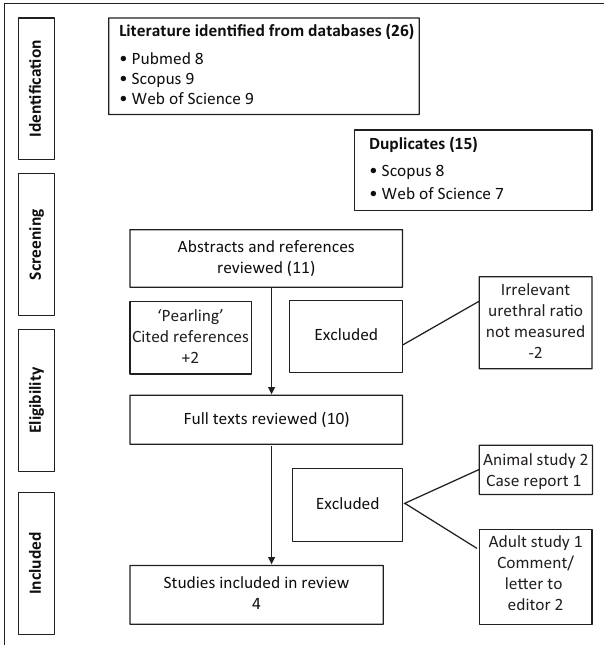
FIGURE 2: Flow diagram demonstrating how the systematic review of the posterior:anterior urethral ratio on voiding cystourethrogram from the PubMed, Web of Science and SCOPUS databases was